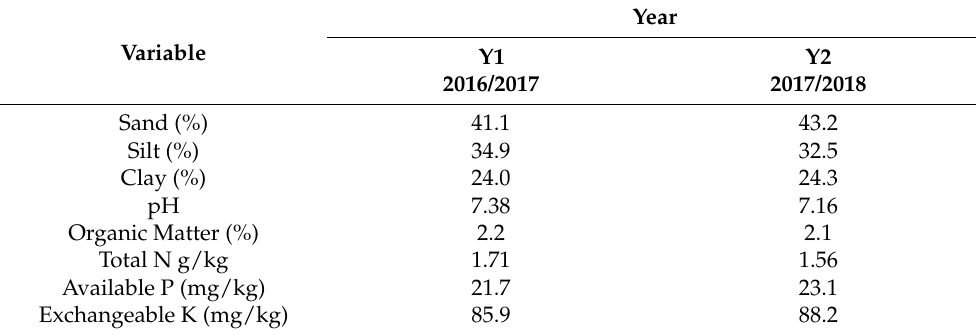
Table 1. Soil features (0–30 cm of depth) at the beginning of the experiment in the two test years.